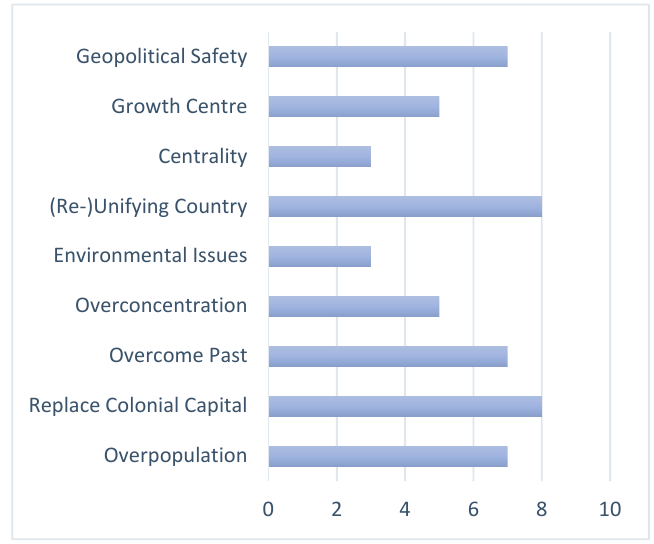
Figure 4. Frequency of reasoning for the capital relocation.